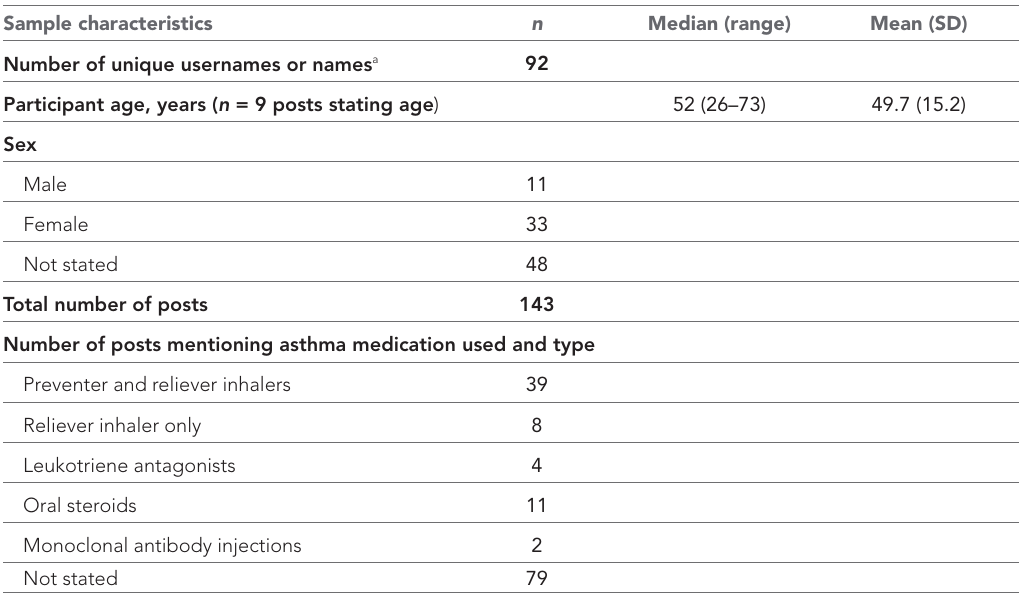
Table 1 Sample characteristics of the Asthma UK community participants and posts Sample